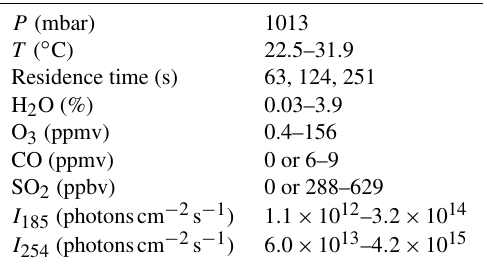
Table 1. OFR conditions input to photochemical